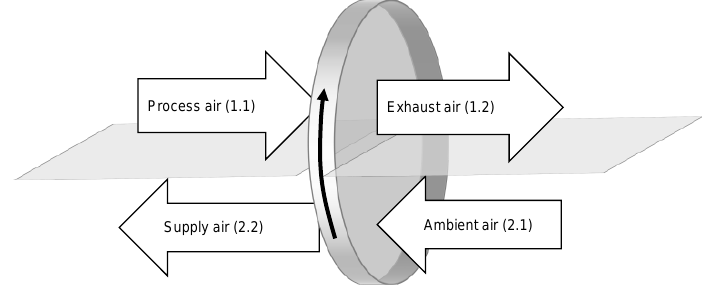
Figure 1. RHX working principle and stream names.